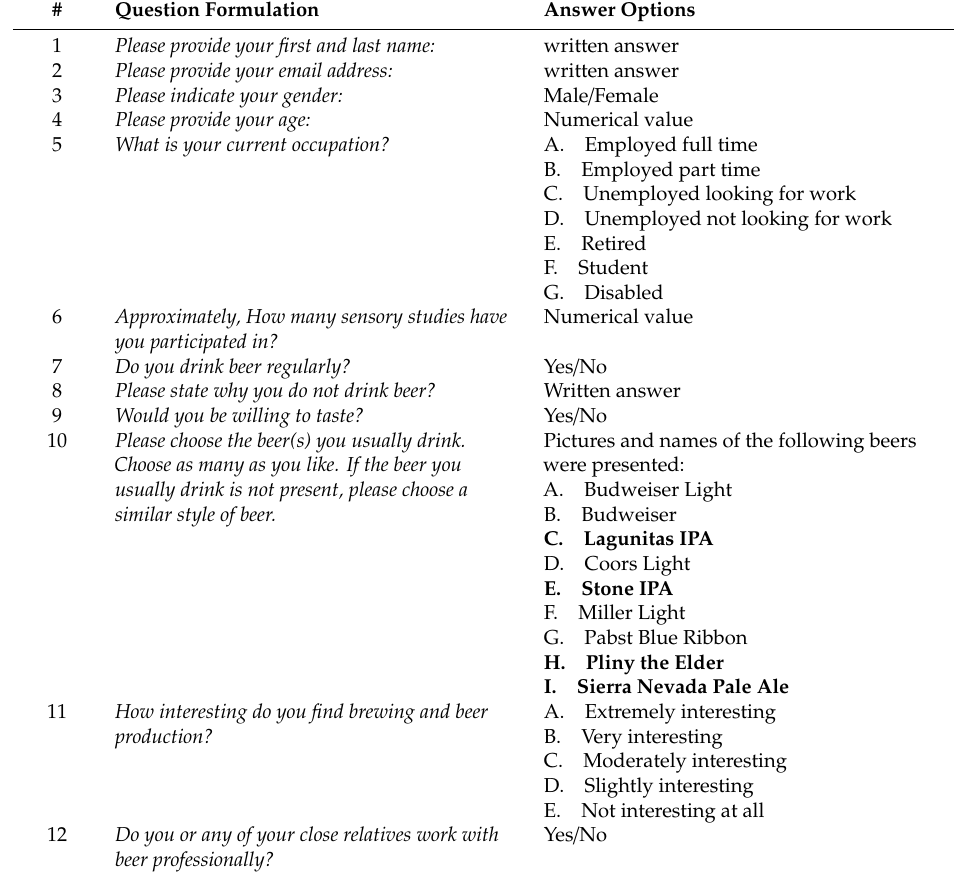
Table A1. Overview of the screening questionnaire content.